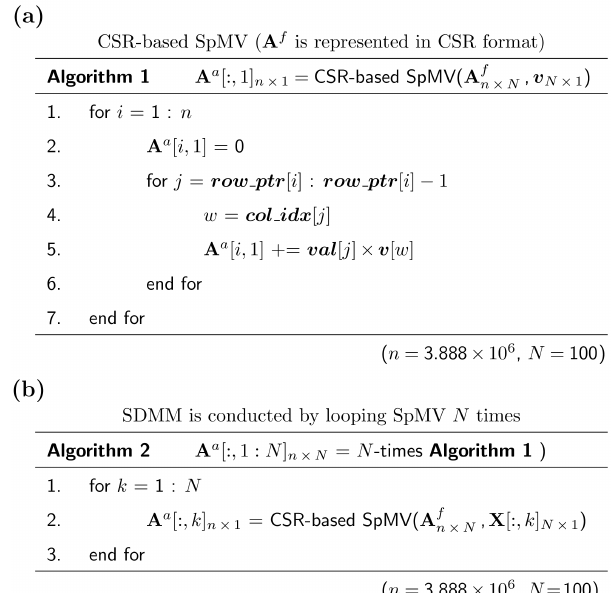
Figure 3. Characteristics of a volcanic ash state.